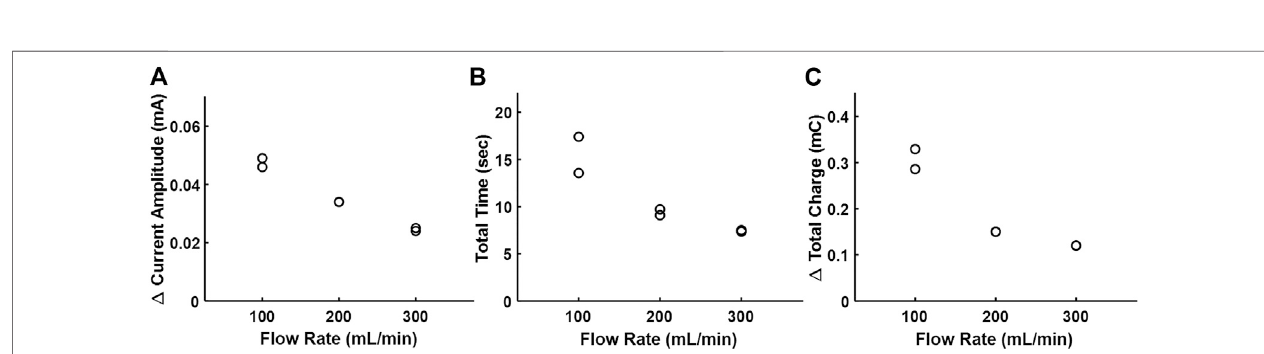
FIGURE 6 | Effect of the increasing fl ow rate of bovine blood on the electrodilution metrics. (A) Δ Current amplitude, (B) total time, and (C) Δ total charge. All measurements were carried out at AC voltammetry settings of 0.1 V pk and 0.5 kHz.